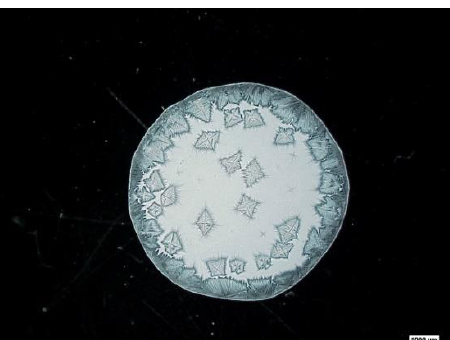
Figure 8—Alumina drop on glass. The bar shown is 1000 µm. Initial concentration of alumina is 0.40 weight fraction.